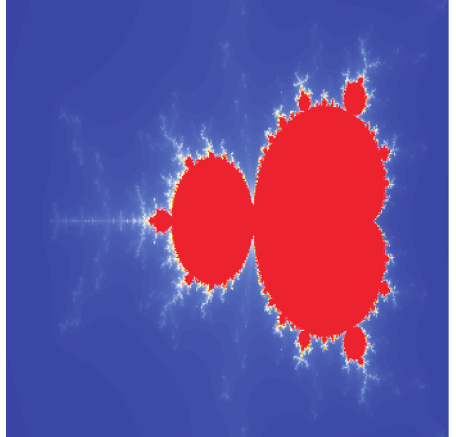
Figure 17: Quadratic Mandelbrot set in